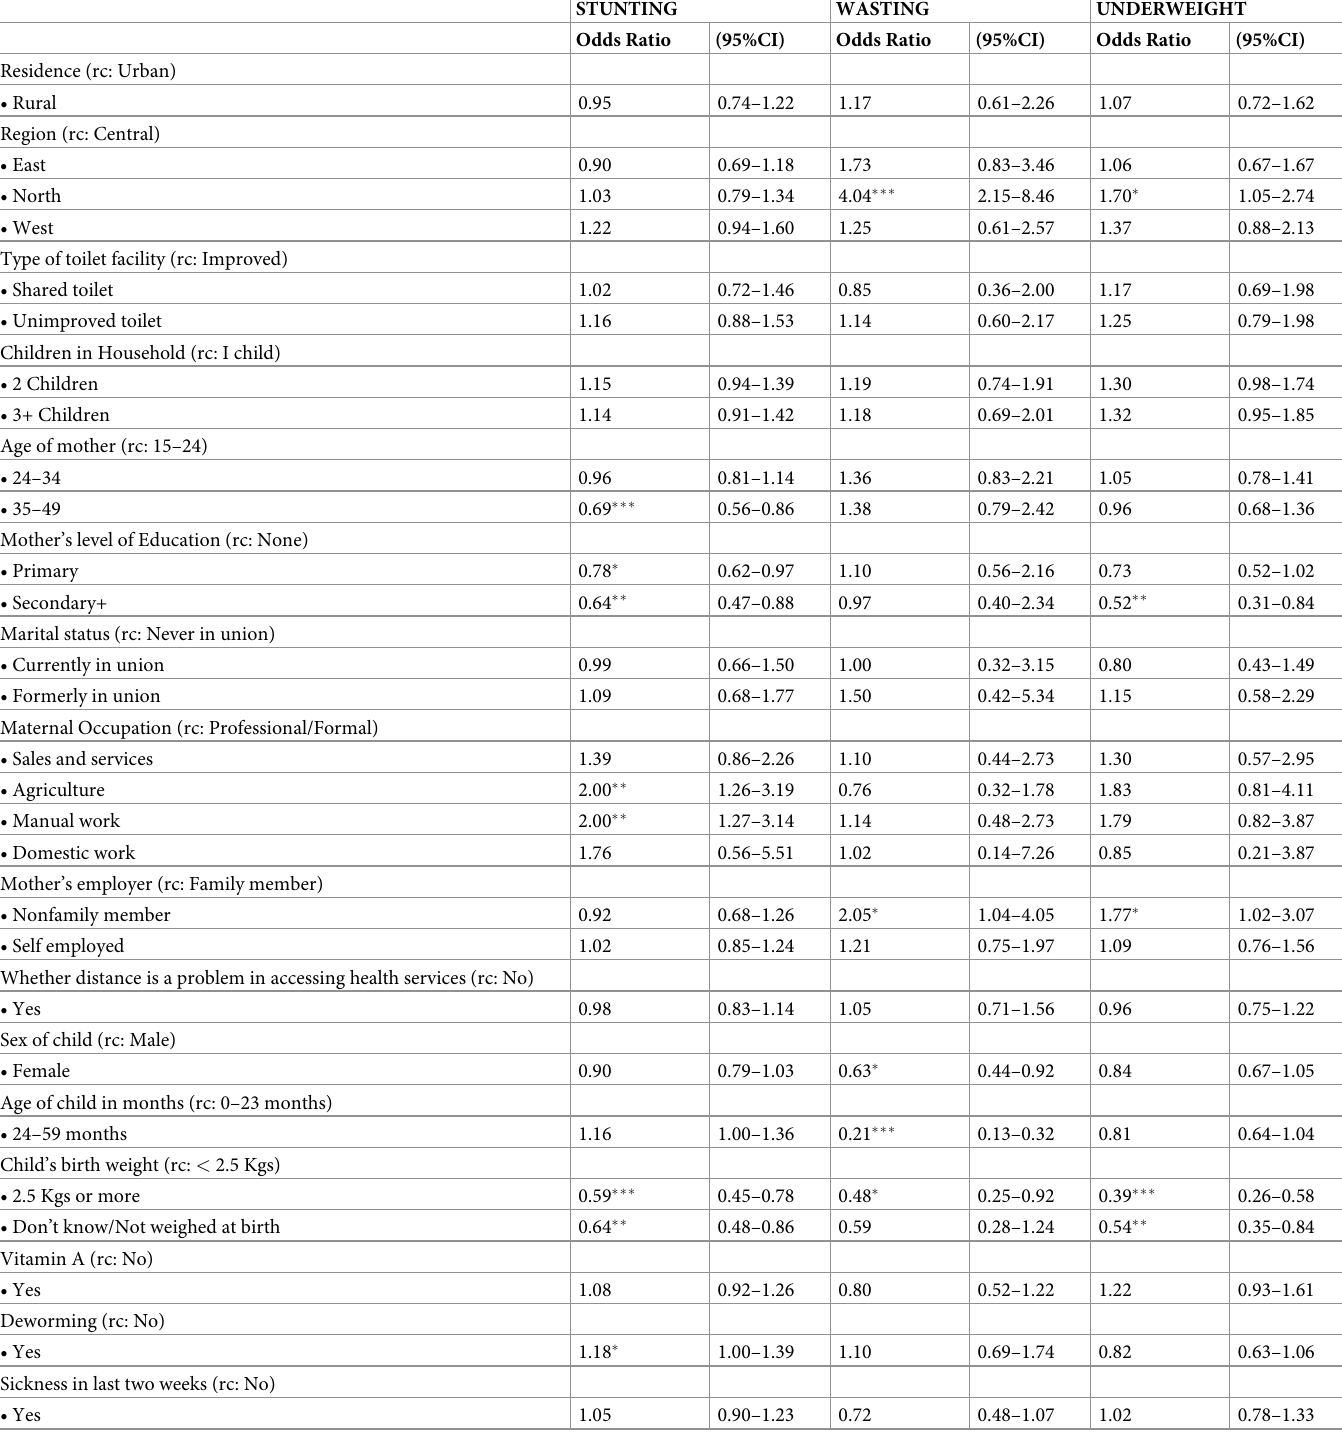
Table 2. Adjusted odds ratios for malnutrition among children age 0–59 months in